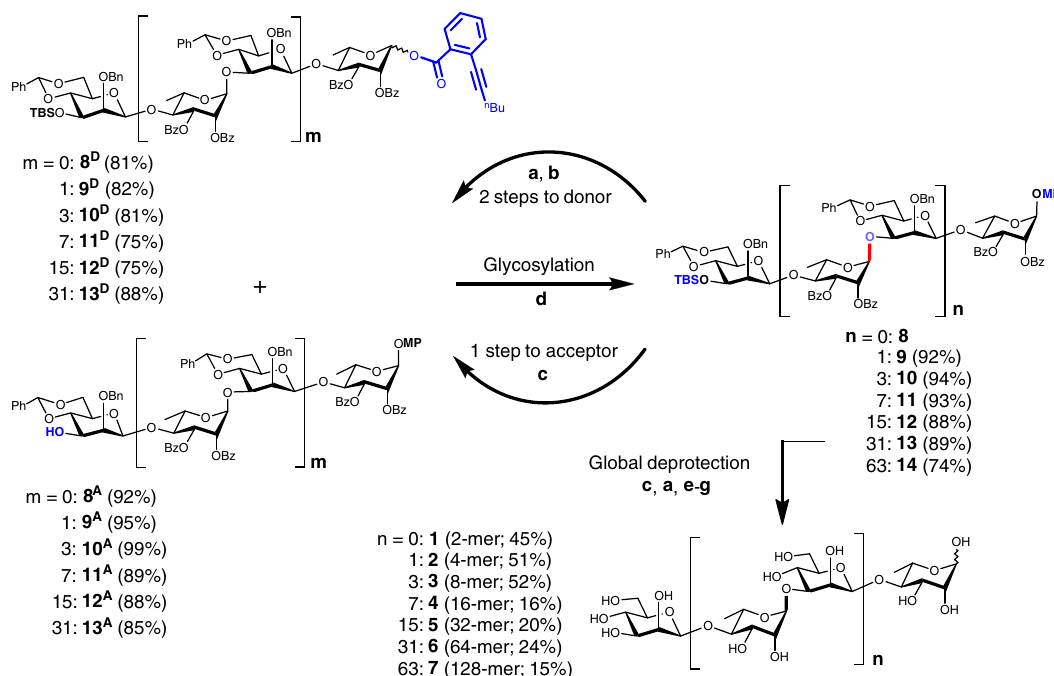
Fig. 2 Iterative assembly to the preparation of glycans up to 128-mer (7). a CAN, CH 2 Cl 2 , MeCN, H 2 O, 0 °C; b o -hexynylbenzoic acid, EDCI, DMAP, CH 2 Cl 2 , rt; c TBAF, HOAc, THF, rt; d Ph 3 PAuNTf 2 (0.1 or 0.2 equiv.), 5 Å MS, CH 2 Cl 2 , 0 °C; e BzCl, Et 3 N, CH 2 Cl 2 , rt; f H 2 , 10% Pd/C (and 20% Pd(OH) 2 ), solvent, rt; g NaOCH 3 , CH 3 OH, rt. The experimental procedures varied slightly for substrates of different sizes (Supplementary Tables 2 – 5), and the hydrogenolysis (step f ) was repeated a couple of times after step g until the benzyl groups were fully removed. CAN cerium (IV) diammonium nitrate, DMAP 4,4-dimethylaminopyridine, EDCI 1-(3-dimethylaminopropyl)-3-ethylcarbodiimide hydrochloride, MS molecular sieves, rt room temperature, TBAF tetrabutylammonium fl uoride, THF tetrahydrofuran. The newly synthesized glycosidic bond is highlighted in red, and reacting functional groups in blue. Source data are provided as a Source Data fi